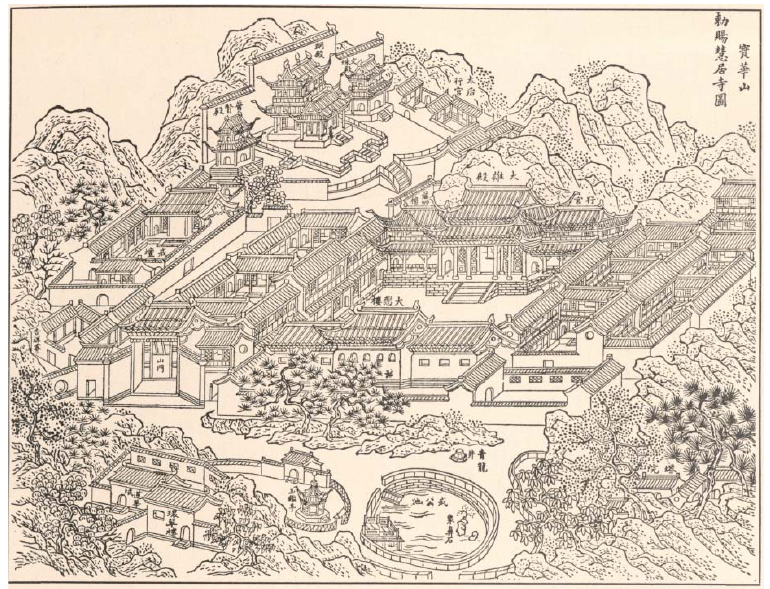
Figure 1. The picture of Longchang Monastery of Mount Baohua. Chinese, wood ‐ block print, book illustration, the eighteenth century (Prip ‐ Møller 1937, p. 197, Figure 237; BHSZ [1795] 1975, vol. 1).